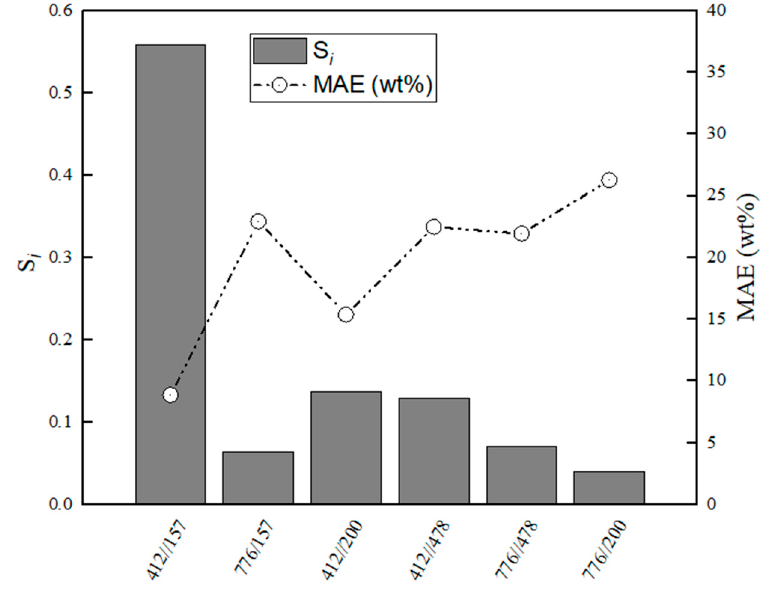
Figure 11. Evaluation of relative stabilities (Si) of the calibration variable candidates and mean absolute error values obtained for training and validation sets for MA–CaS.